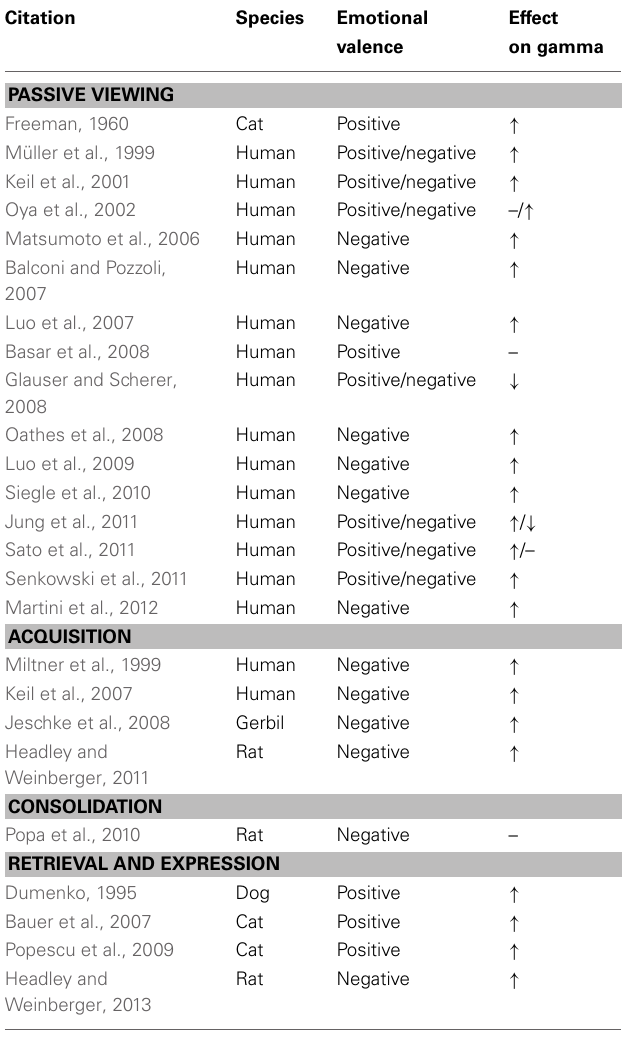
Table 1 | Summary of cited literature on gamma oscillations and emotional